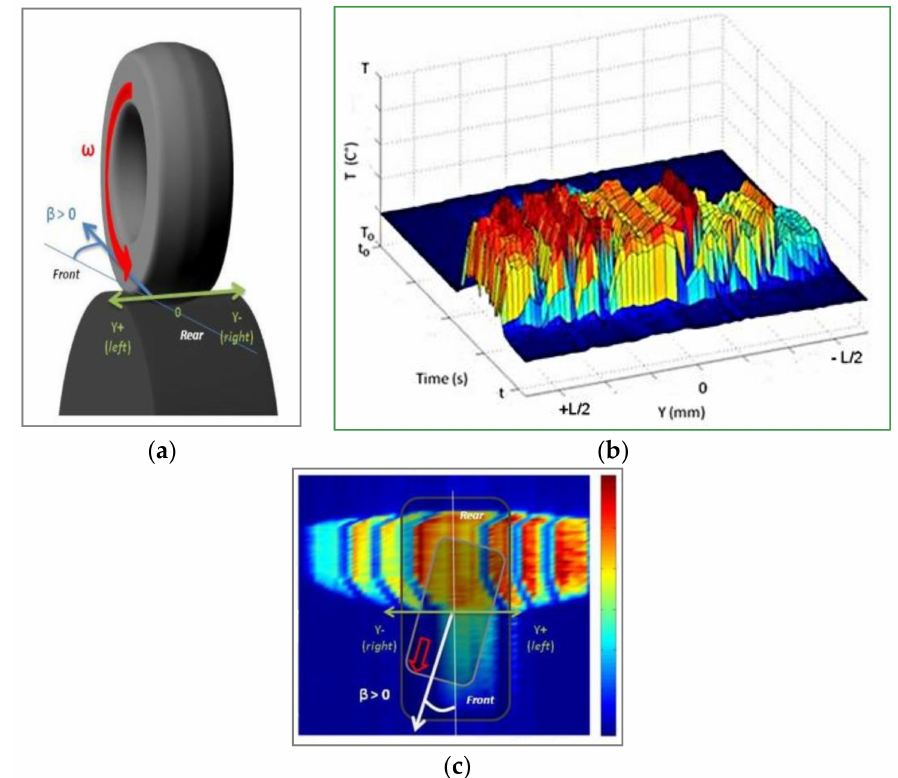
Figure 4. Experimental set-up: ( a ) tire/drum configuration ( b ) temperature distribution in the contact zone, ( c ) the thermal evolution of contact